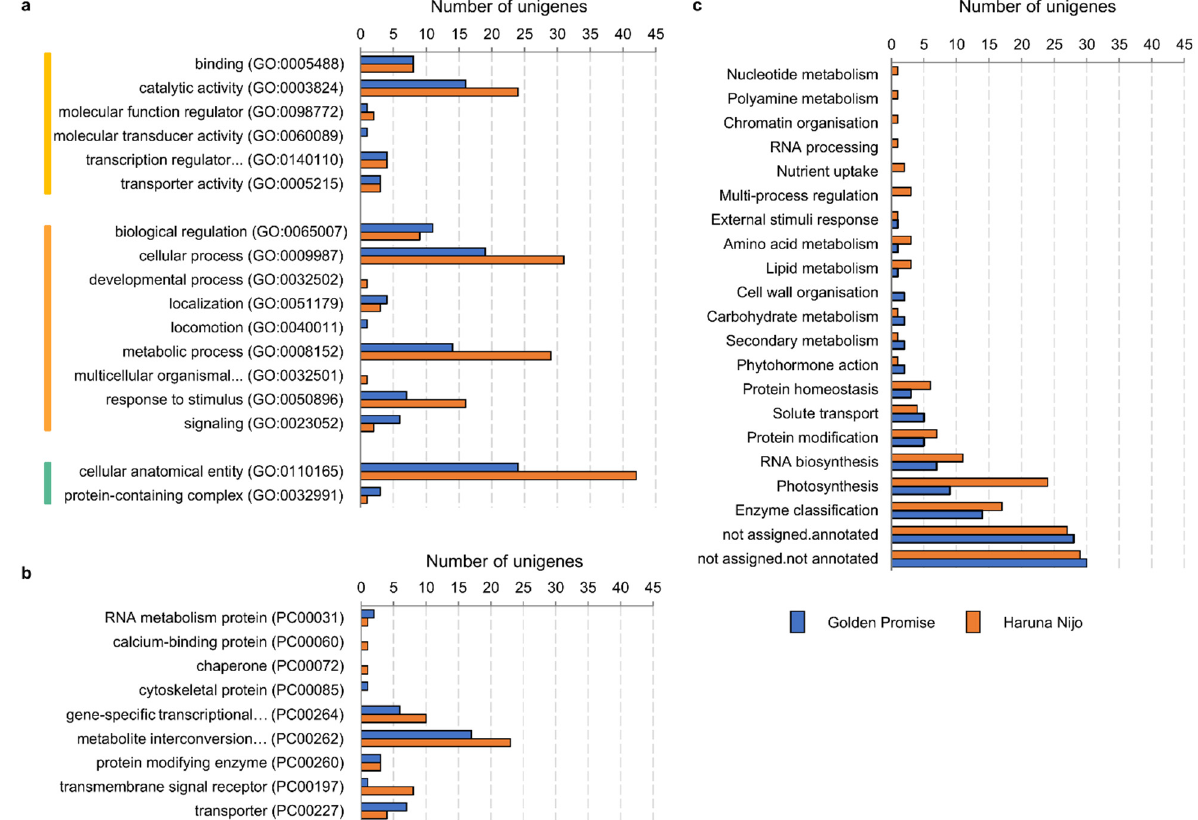
Figure 6. Treatment with bikinin resulted in molecular changes in barley grown under salt stress conditions. Molecular function (yellow), biological process (orange), and cellular component (green) ( a ); protein class ( b ); and gene classification ( c ) after treatment with 10 µM and 100 µM bikinin compared to controls with 0.11% DMSO used as a background for the solvent solutions for each bikinin concentration. Non-treated plants were used as a control for the 0.11% DMSO treatment. Results represent the means for three biological replicates. Raw data are presented in Tables S3 and S4.